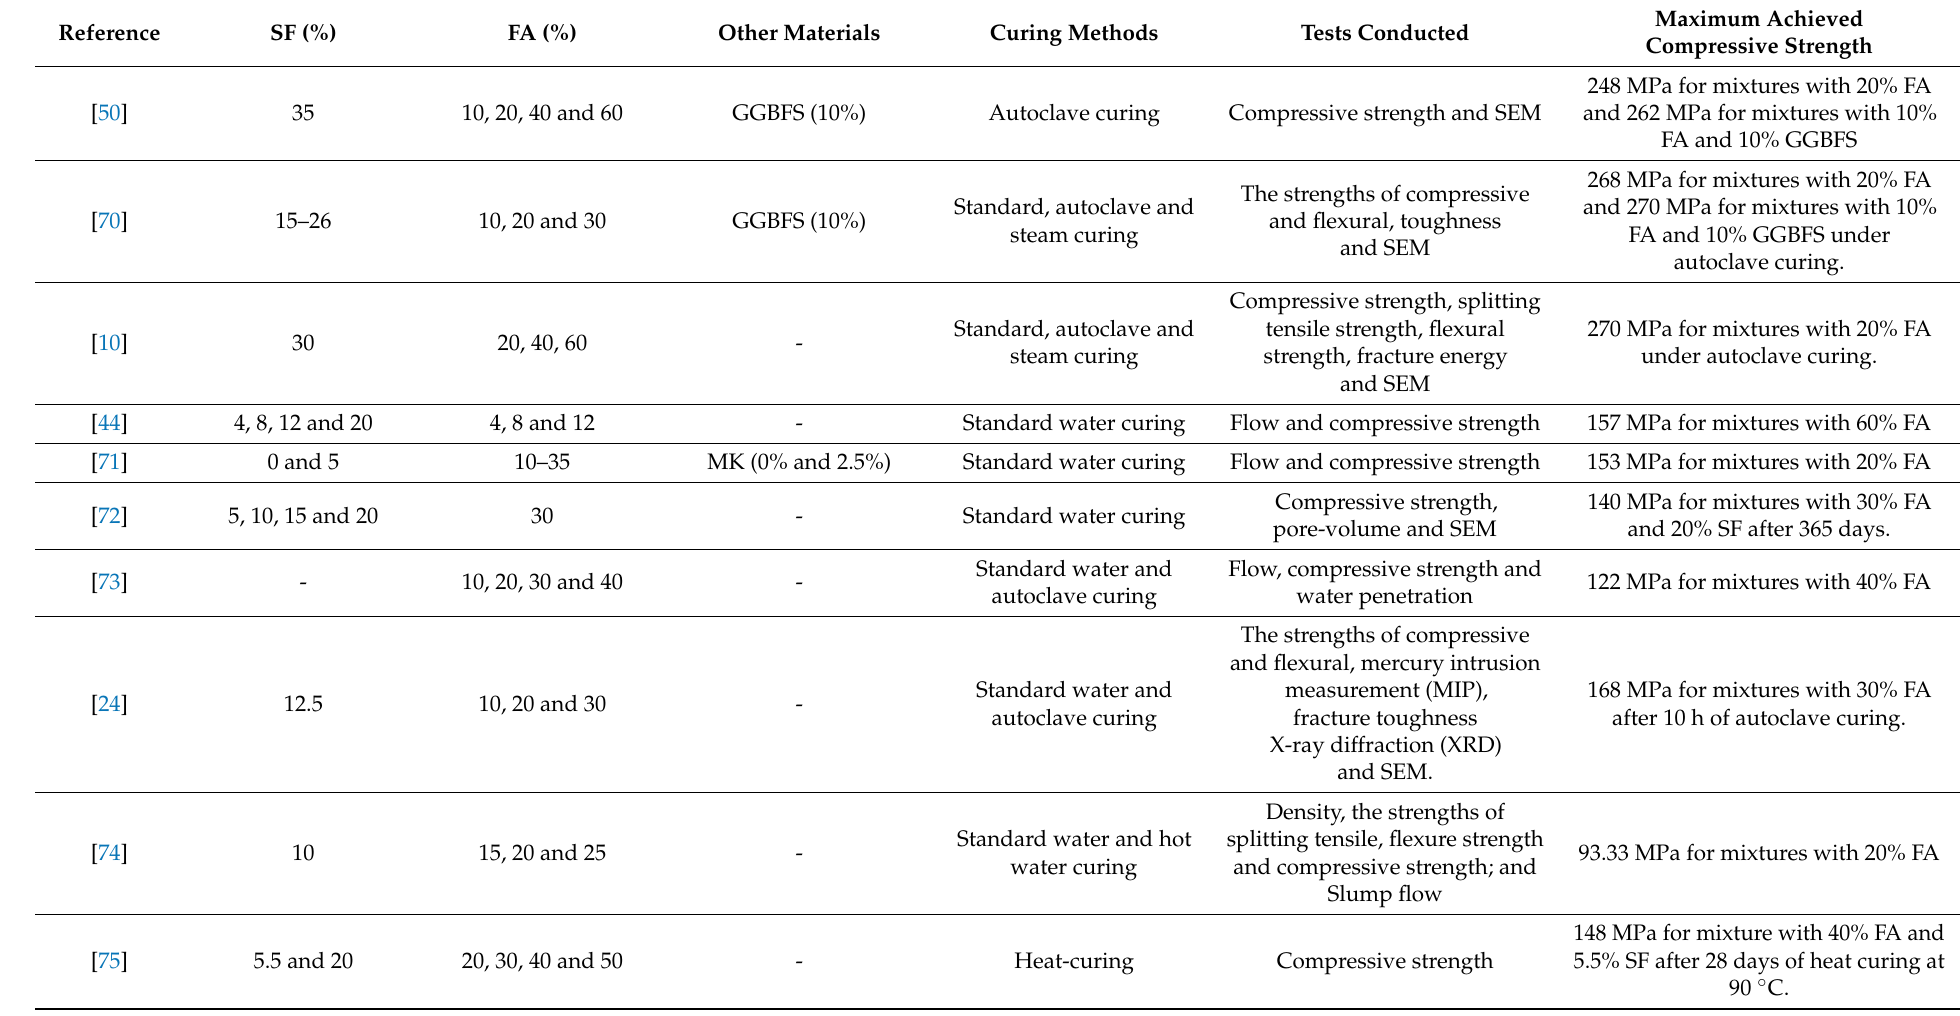
Table 1. Investigates on the utilization of FA in the production of